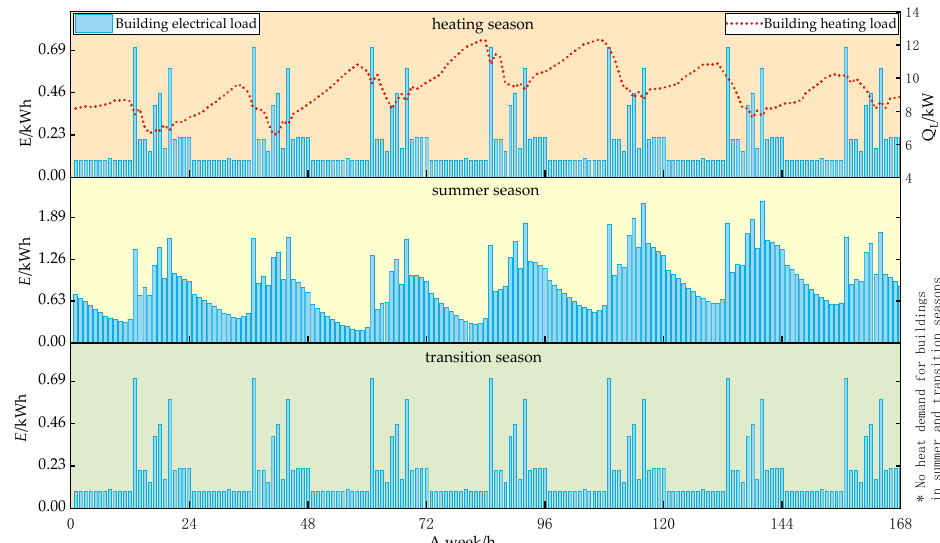
Figure 5. The typical building and the Energy Plus model diagram.